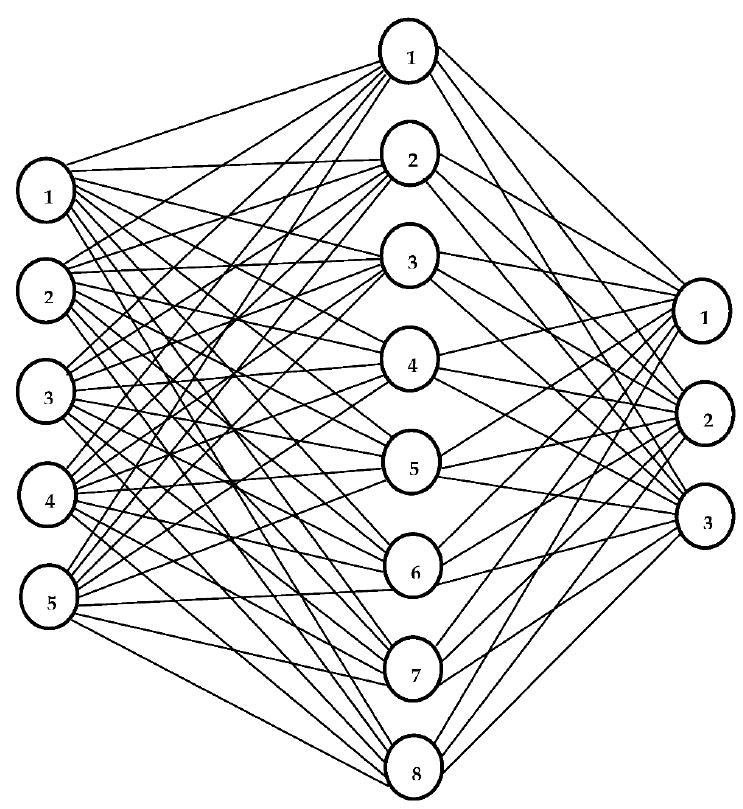
Figure 2. Demonstrates an example of a